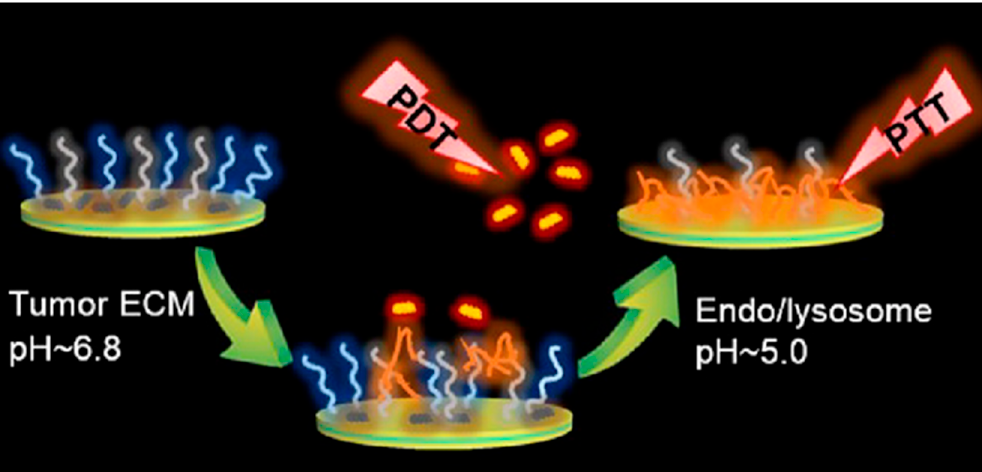
Figure 16. Illustration of the antitumor effect with toluidine blue O release and photo-induced reactive oxygen species generation of a multifunctional nanocarrier system in acidic pH. Reproduced with permission from [211]. Copyright 2017, American Chemical Society.